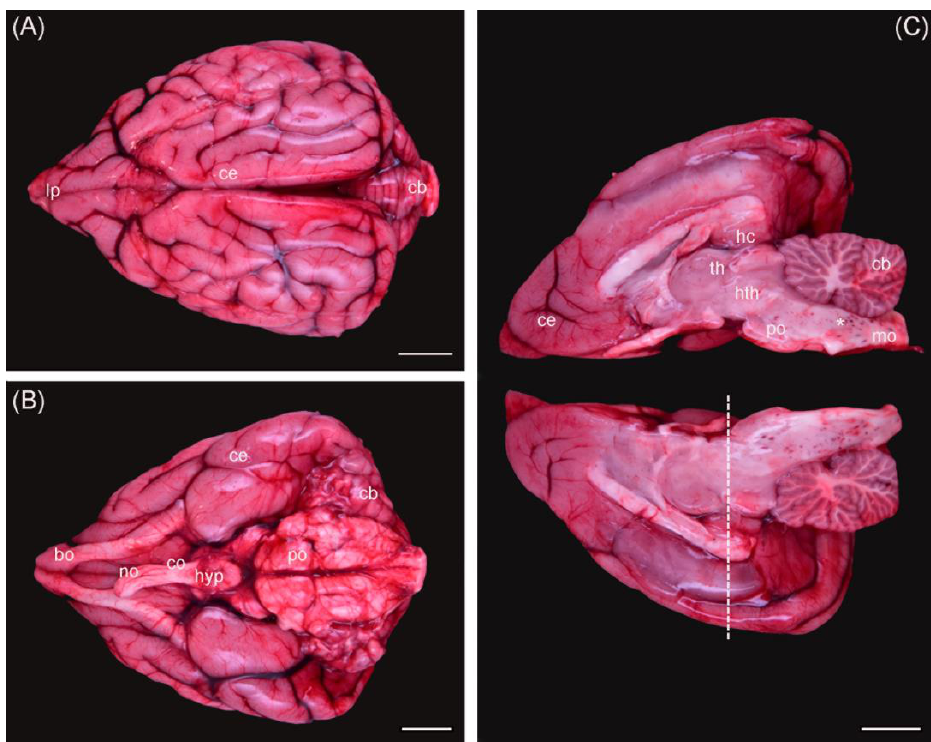
Figure 1. Otter brain dorsal view ( A ), ventral view ( B ), and medial view of both hemispheres ( C ). Ce = cerebrum; cb = cerebellum; bo = bulbus olfactorius; co = chiasma opticum; no = nervus opticus; hyp = hypophysis; po = pons; mo = medulla oblongata; th = thalamus; hth = hypothalamus; hc = hippocampus; * = hemorrhages. Dashed line = coronal section used for histology. Scale bar equals 1 cm in all views. The background was removed manually.